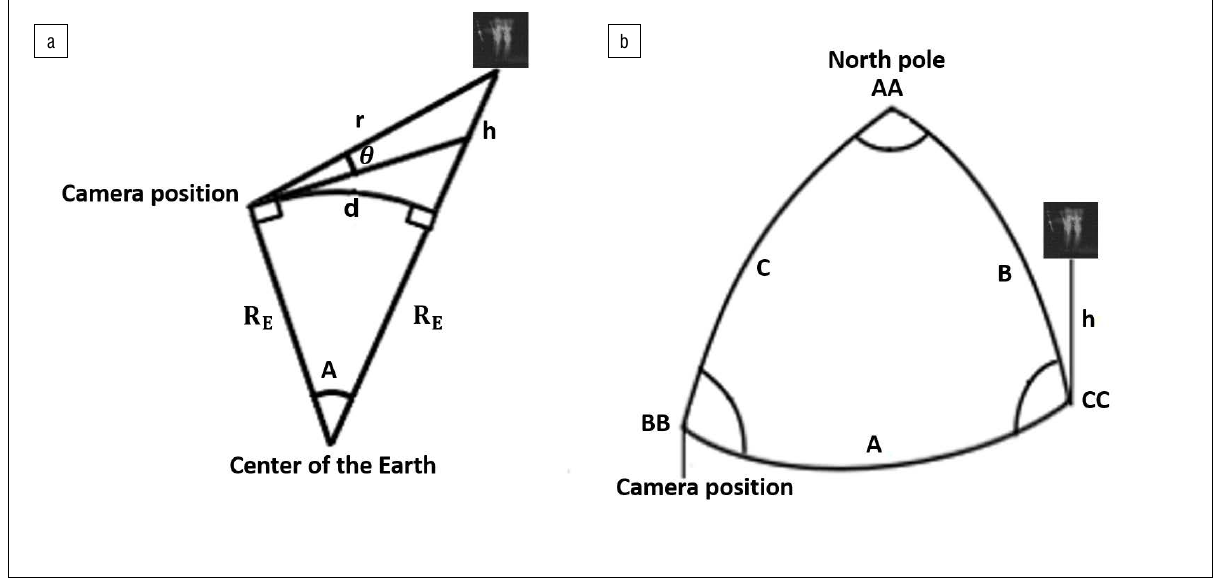
Figure 2: Schematic representation of basic triangles on a sphere: (a) altitude of the sprite vertical axis and (b) horizontal